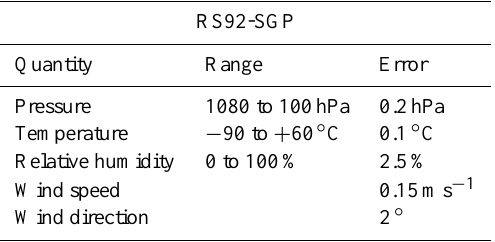
Table 1. Vaisala RS92-SGP (Vaisala, 2015) sensors specifications in range pressure of 1080–100hPa.